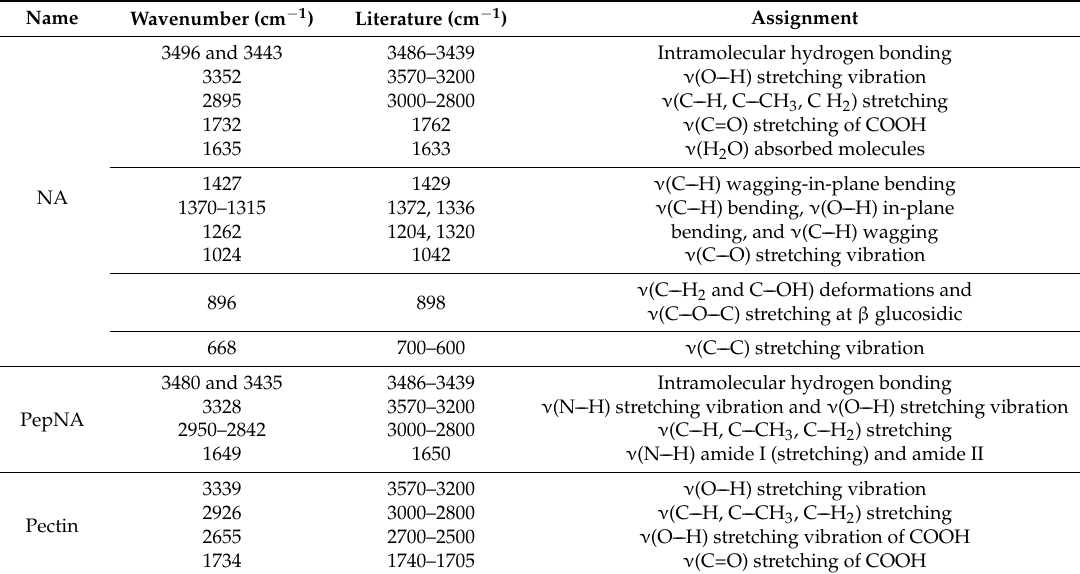
Figure 4. ATR-IR spectra of NA (blue), PepNA (pink) and pectin (green). Table 2. Characteristic ATR-IR bands for the NA, PepNA and pectin.